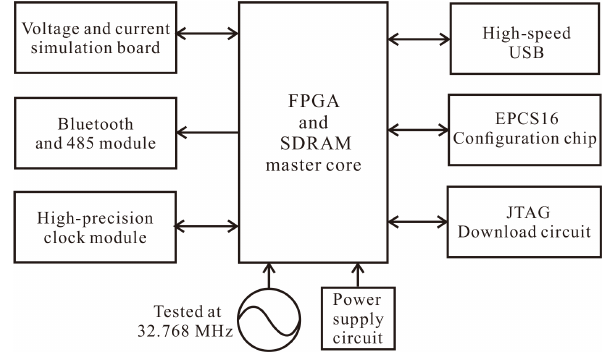
Figure 3. Schematic circuit diagram of high-speed optocoupler iso- lation.